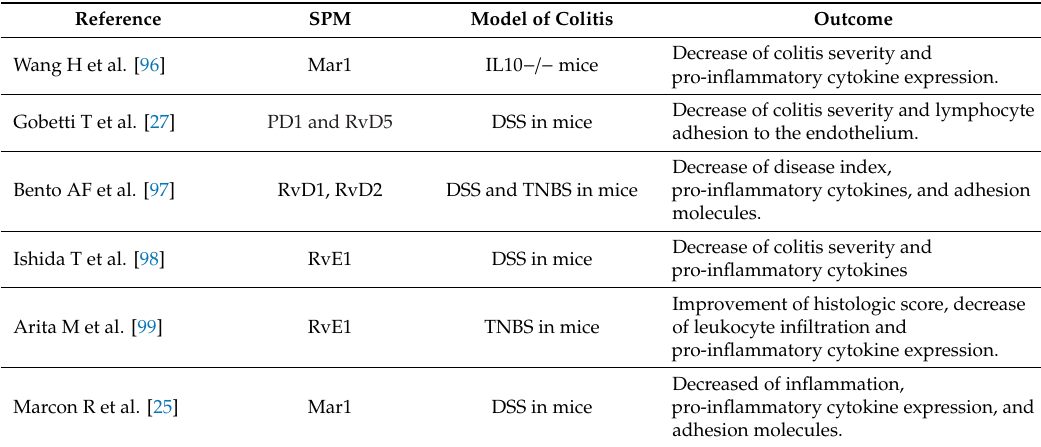
Table 1. The role of SPMs in experimental models of colitis. Maresin (Mar); Protectin (PD), Resolvin (Rv), Dextran sulphate sodium (DSS), 2,4,6-Tri-nitro-benzene sulphonic acid